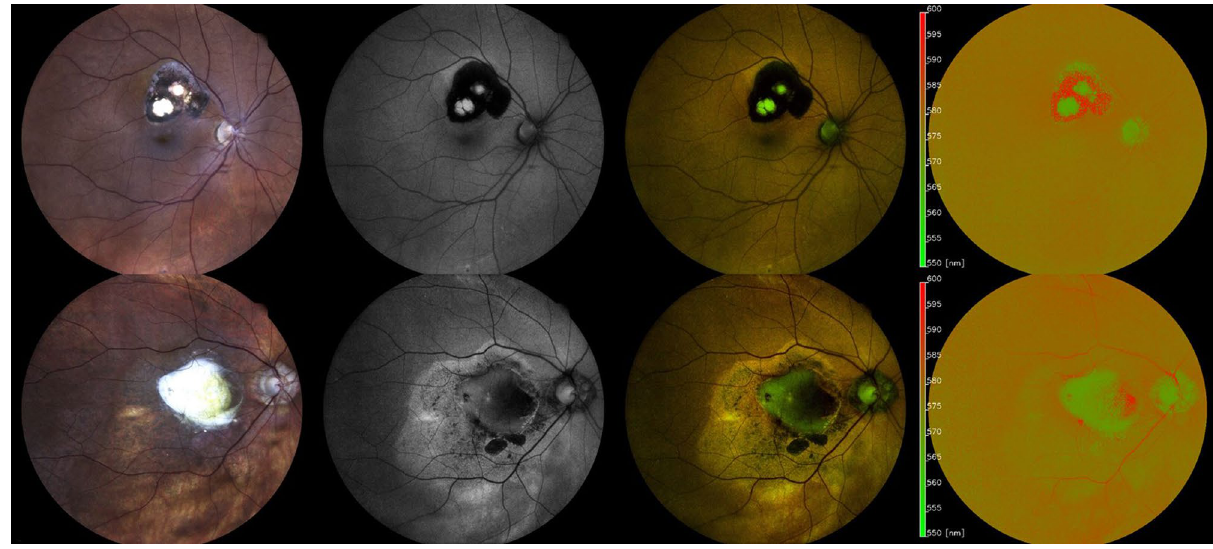
Figure 3. Sources of green and red emission fluorescent components in posterior uveitis. Exemplary eyes with a pigmented scar in toxoplasmosis chorioretinitis (top row) and with macular neovascularization (MNV) in multifocal choroiditis and panuveitis (MCP; bottom row). From left to right: color fundus photography (CFP), grayscale fundus autofluorescence (grayscale FAF), spectrally resolved fundus autofluorescence (Color-FAF) image, intensity-normalized Color-FAF. Pigmented parts of the toxoplasmosis lesion features predominantly red emission fluorescent components (REFC) on intensity-normalized Color-FAF. On grayscale FAF and Color- FAF the pigmented parts were hypoautofluorescent and indistinguishable from parts of the lesion without pigmentation. The MNV in the eye with MCP featured mainly GEFC on Color-FAF and intensity-normalized Color-FAF.